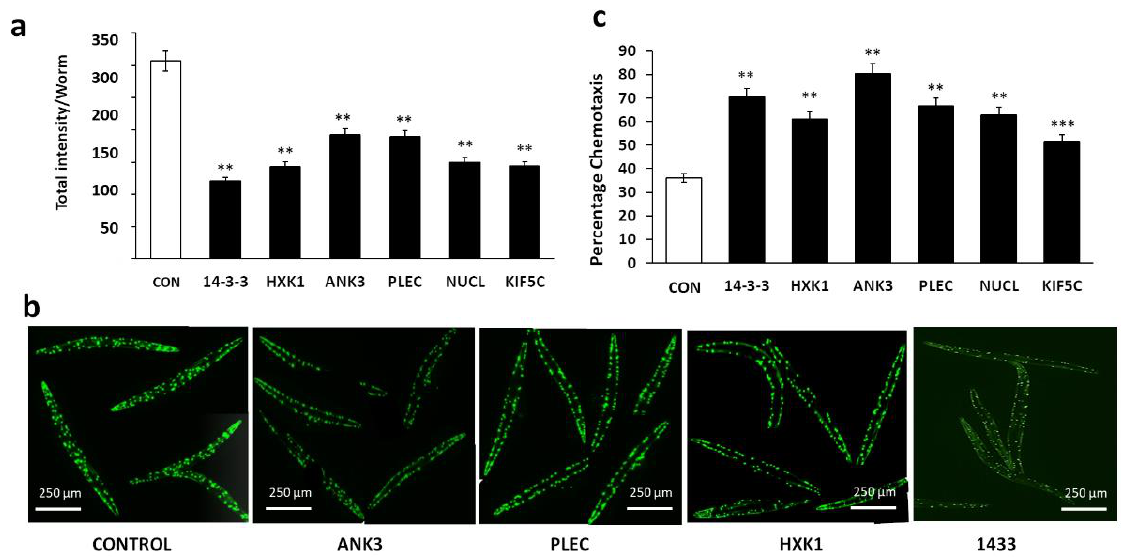
Figure 3. Knockdowns of influential aggregate hubs reduce aggregation in C. elegans . ( a ) Intensity per worm of aggregates in AM141 adults after exposure (starting in larvae) to RNAi constructs; 13 < N < 18. ( b ) Images of AM141 worms showing decreased size and number of aggregates after exposure to RNAi constructs. ( c ) Chemotaxis of C. elegans strain CL2355 adults (100 < N < 200) after treatment with the indicated RNAi. Significance based on two-tailed t -test ( a ) or Fisher exact test ( c ): ** p < 10 − 3 ; *** p < 10 − 7 .